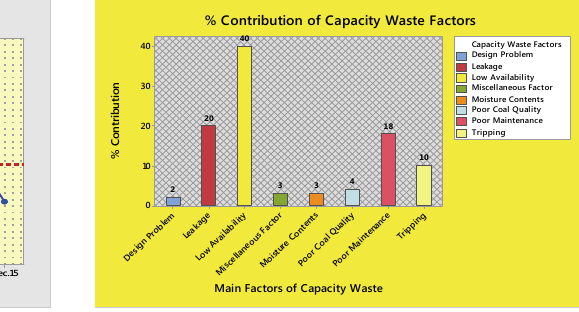
Fig. 3. Capacity Waste Analysis Fig. 4. Percentage Contribution of Capacity Waste